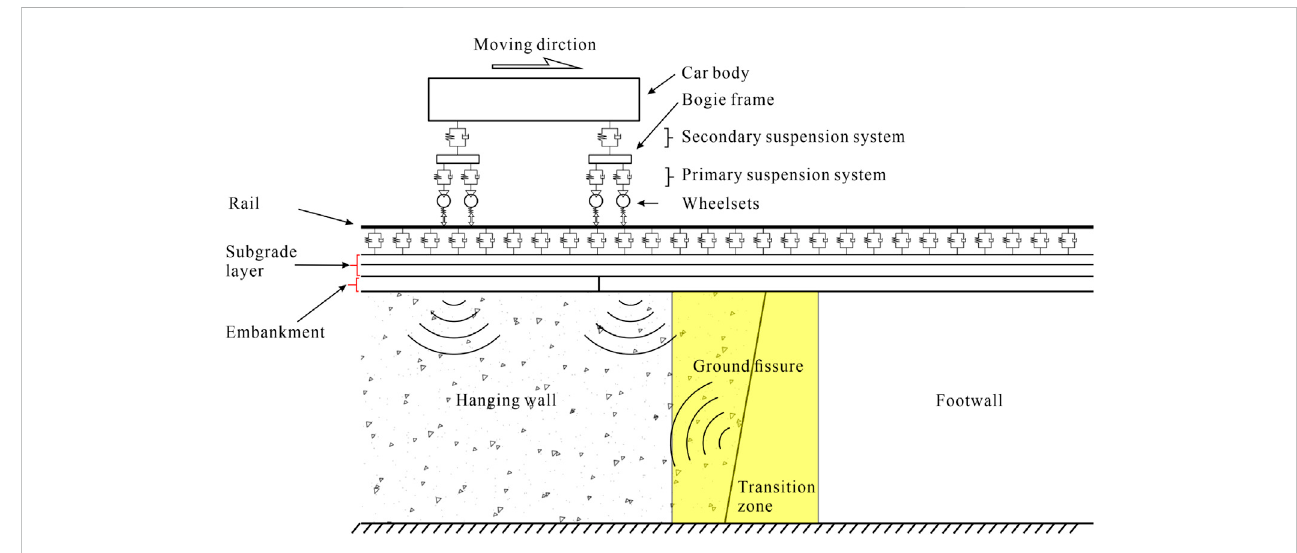
FIGURE 10 Schematic diagram of dynamic ampli fi cation effect of ground fi ssure